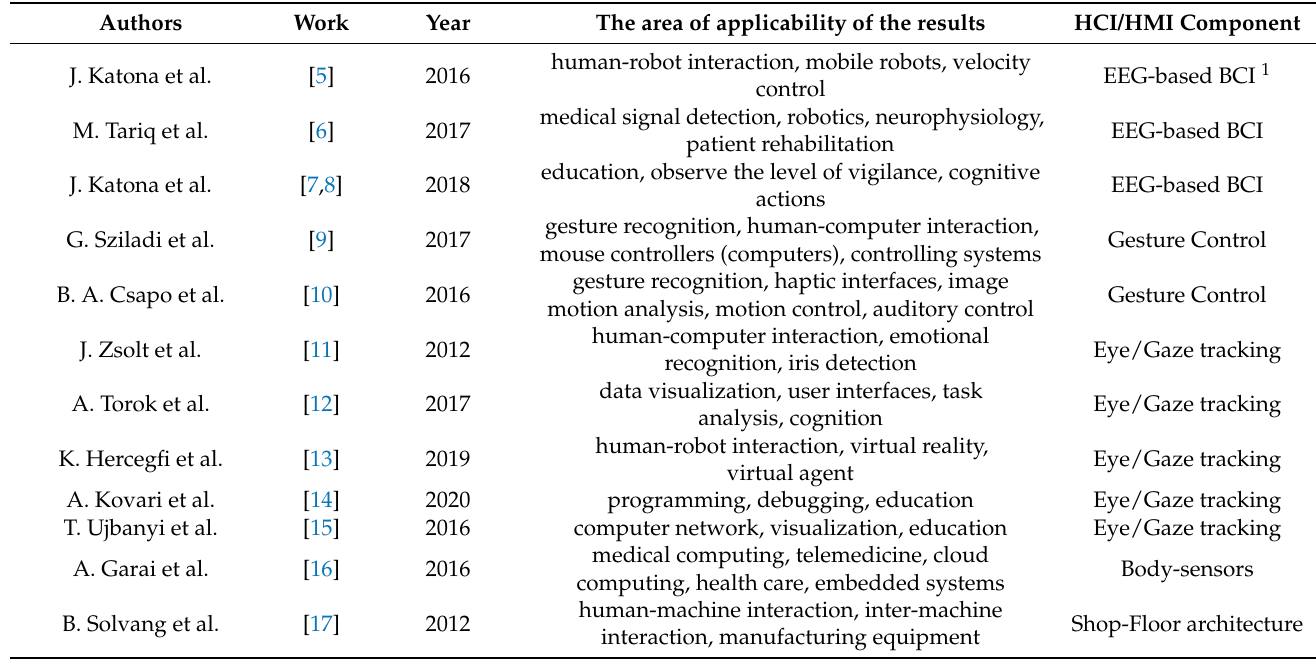
Table 2 summarizes the year of reviewed publications of this section, the area of applicability of the obtained results, and the applied HCI/HMI components. The area of applicability of the results of the reviewed literature and the applied human–computer interaction/human–machine interaction (HCI/HMI)